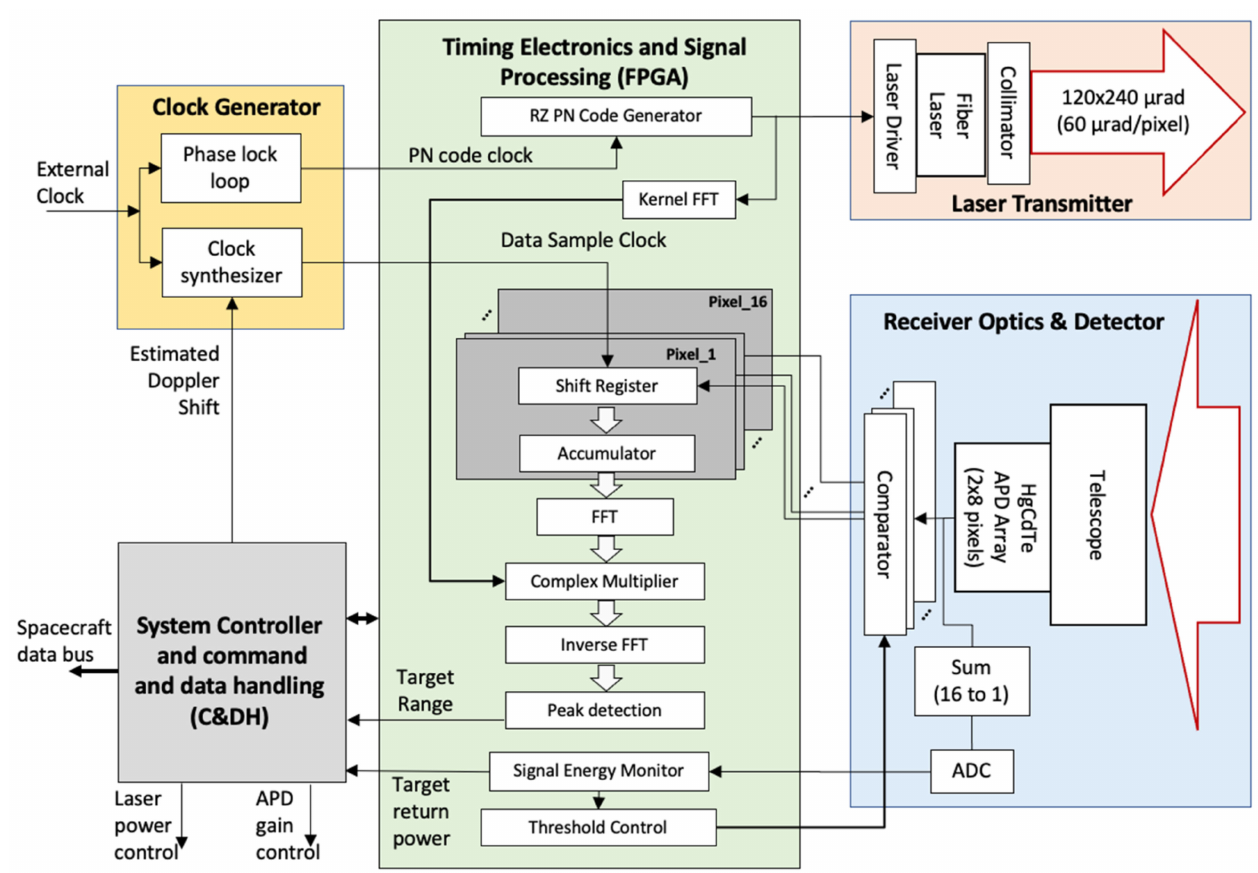
Figure 6. Block diagram of SALi instrument and